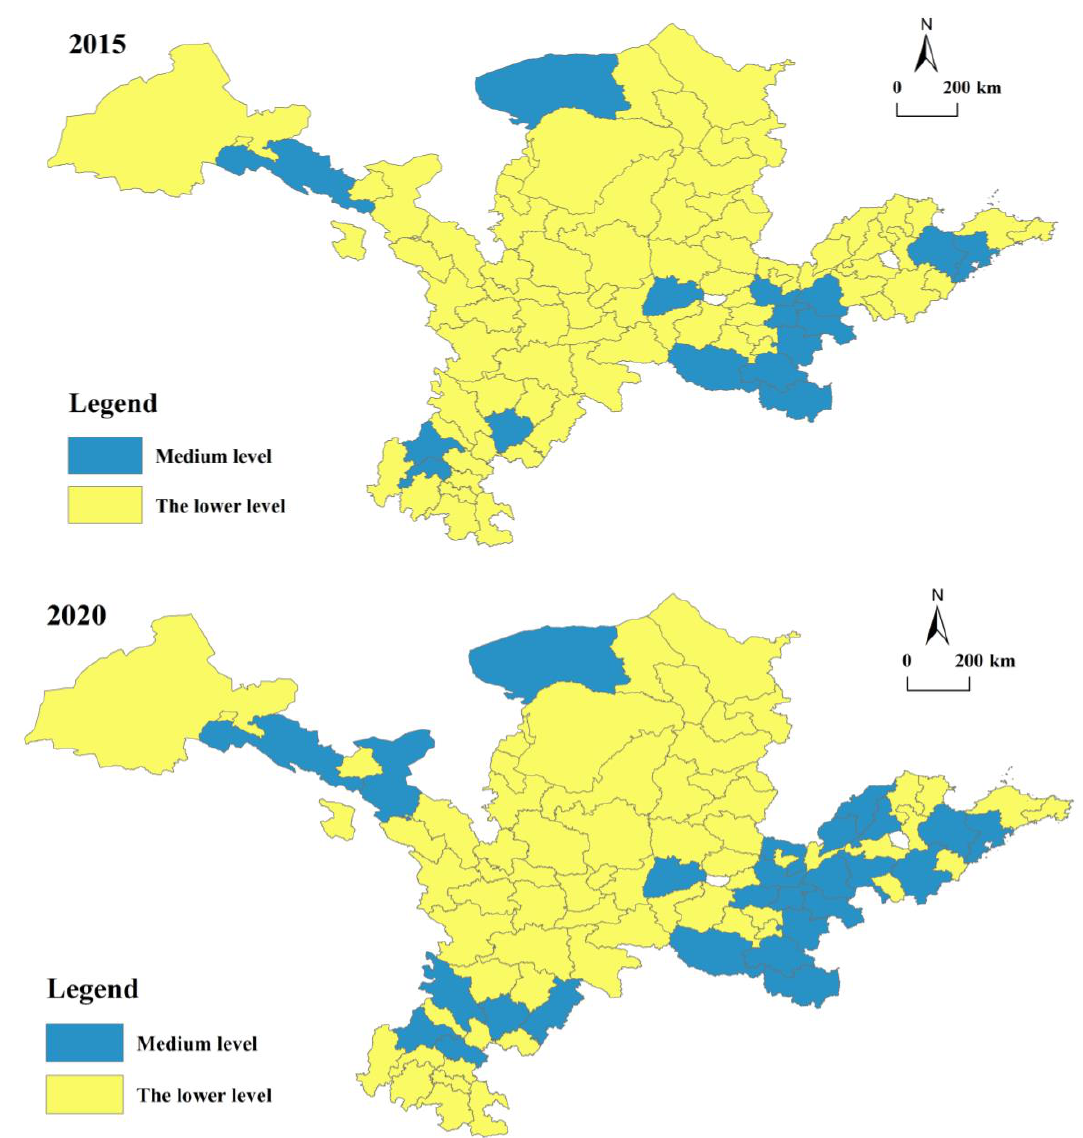
Figure 3. Distribution of rural development levels.